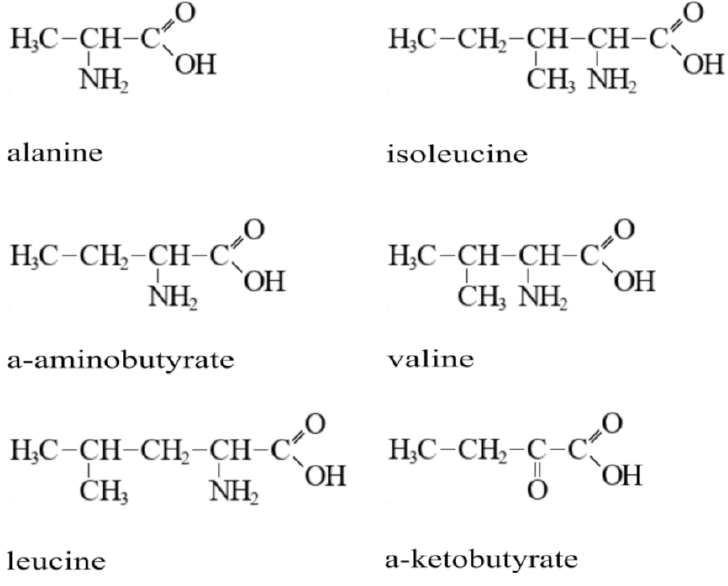
Figure 1. Structural formulas of L -alanine and structurally analogous